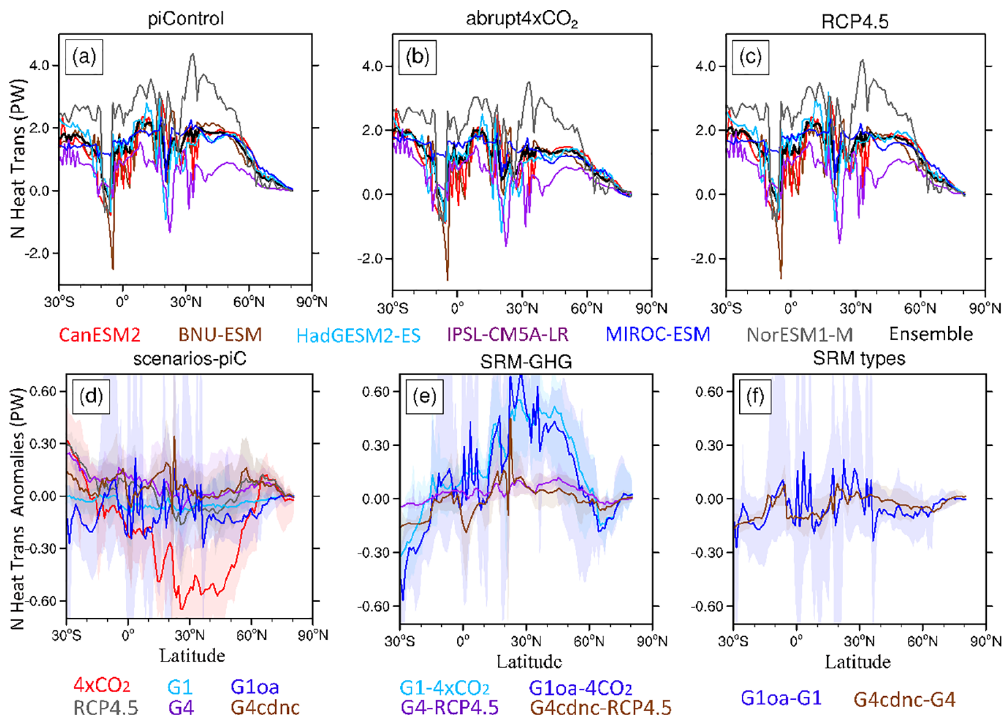
Figure 3. Meridional distribution of the average northward heat transport (PW) over the 40-year analysis period at Atlantic Ocean (depth 0– 700m) under (a) piControl, (b) abrupt4 × CO 2 , and (c) RCP4.5. Panels (d) – (f) show northward heat transport anomalies relative to the other scenarios: left column (d) relative to piControl; middle (e) relative to global warming scenarios; right (f) relative to other geoengineering scenarios. Colored bands in panels (d) – (f) represent the across-ESM